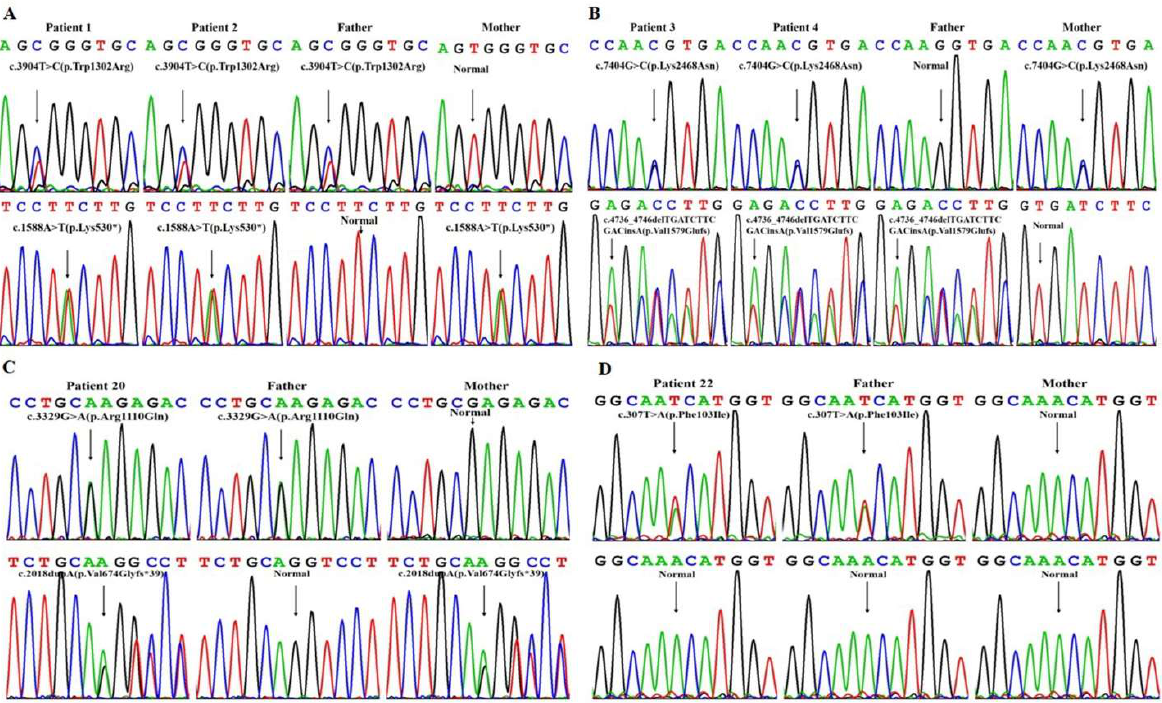
Figure 2. Sanger sequencing results of DUOX2 , TG and PAX8 gene in Patients 1, 2, 3, 4, 20 and 22. ( A ) Patients 1 and 2 were compound heterozygous for the DUOX2 variants c.3904T > C